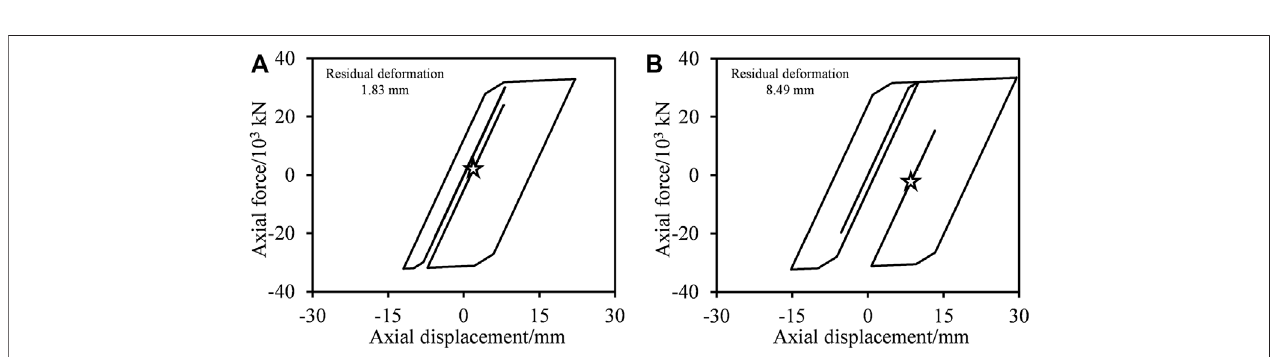
Frontiers in Materials |